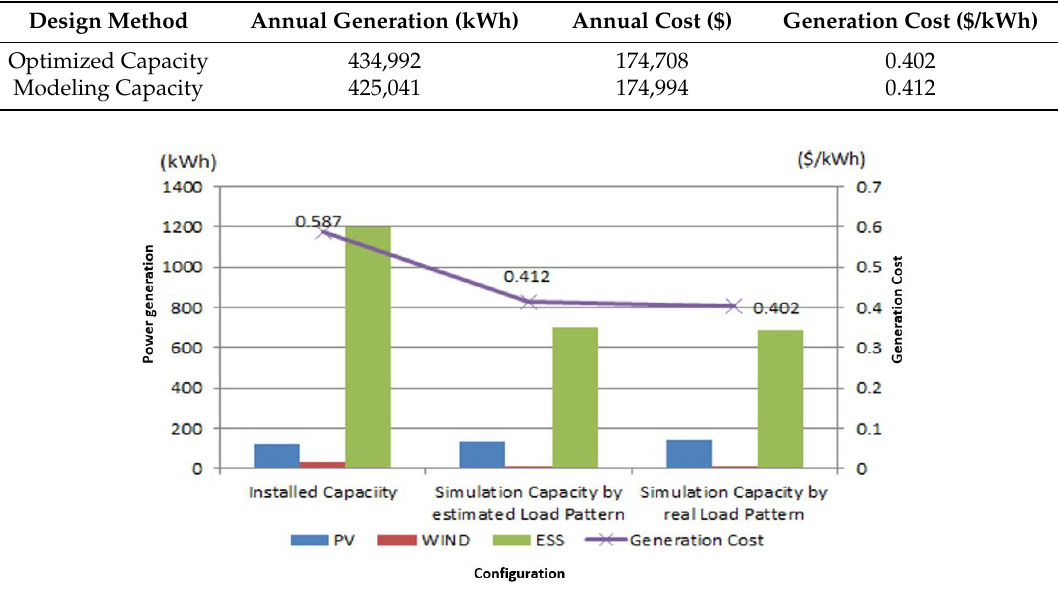
Figure 11. Economic effect ( y axis) of new estimation method for load pattern compared with installed and simulated ones ( x axis: different design methods) by real load pattern for Island 7.